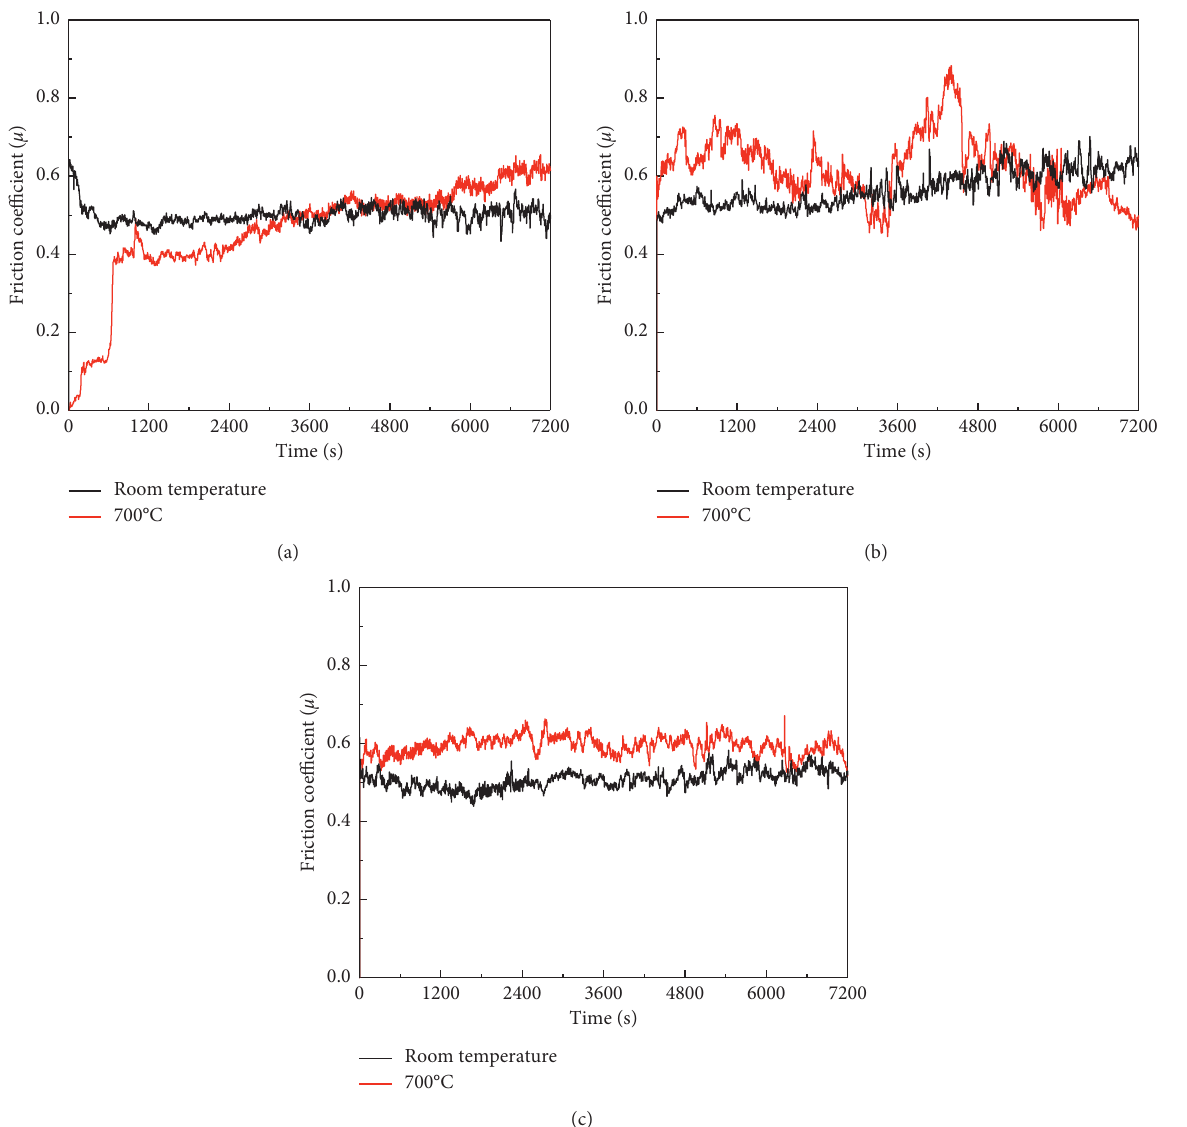
Figure 11: Friction coefficient vs. time curves of coatings at room temperature and 700 ° C: (a) S0 coating; (b) S1 coating; and (c) S2